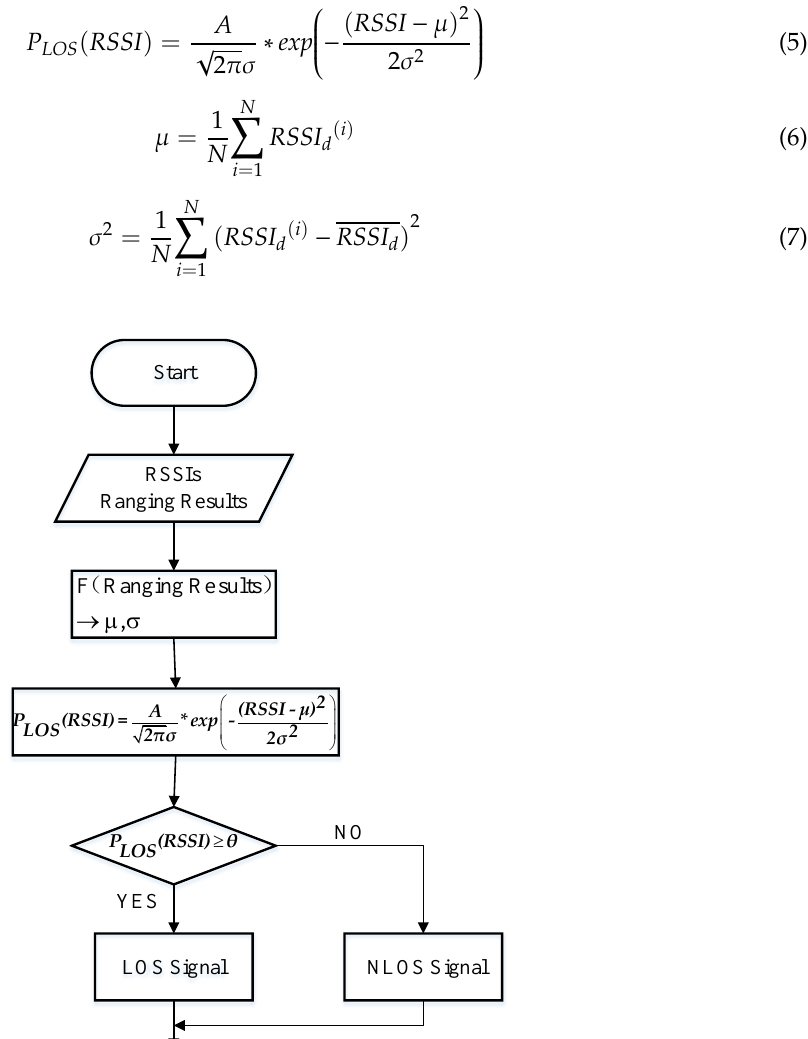
Figure 4. Flow chart of the LOS/NLOS identification process.